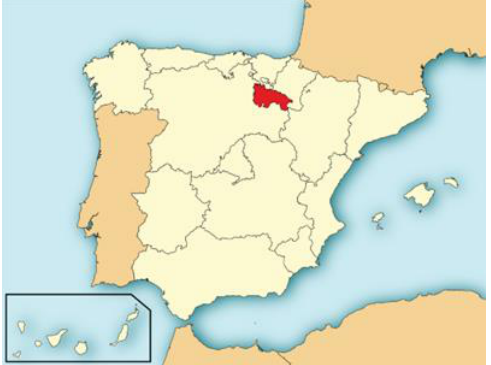
Figure 1. Map of Spain detailing La Rioja. Source: Wikipedia. Author: Mutxamel, uploaded by Rastrojo, https://es.m.wikipedia.org/wiki/Archivo:Localizaci%C3%B3n_de_La_Rioja.svg, accessed on 27 January 2023.